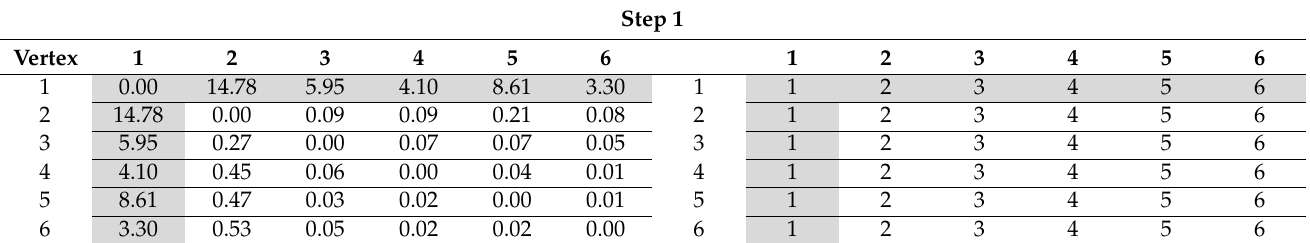
Table A10. The step 1 graphical process of the best search and rescue route.